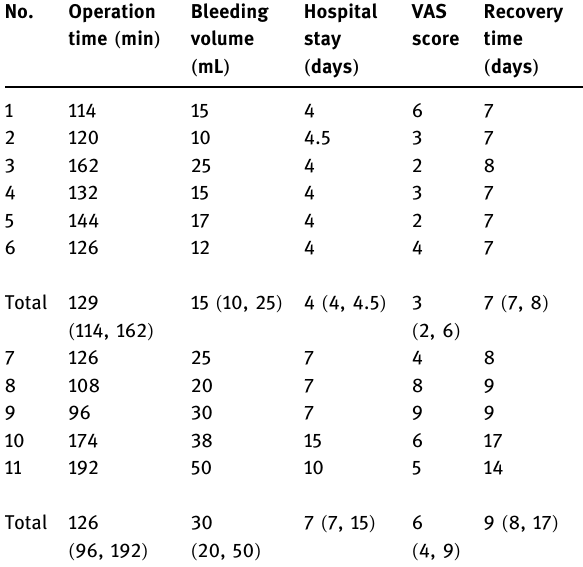
Table 2: Surgical data of the patients